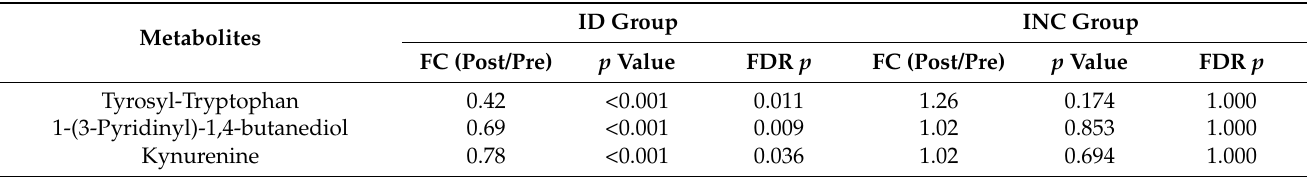
Table 3. Paired t -test for final differential urinary metabolites conducted through a comparison of pre-intervention and post-intervention paired-samples from each child in the ID group and INC group, respectively.